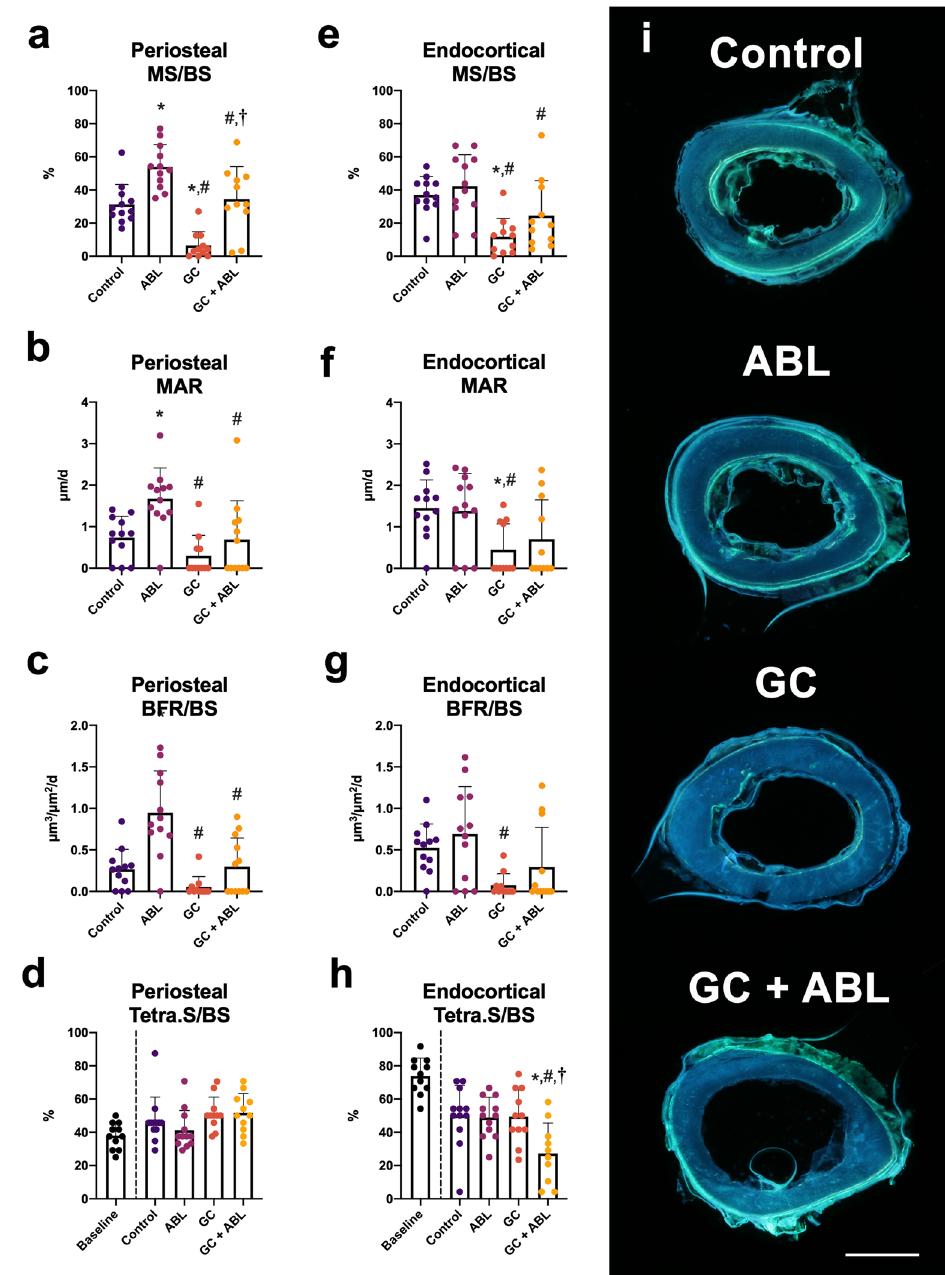
Figure 5. Mid-diaphyseal femoral cortical bone parameters determined by dynamic bone histomorphometry. ( a – d ) Periosteal envelope. ( e – h ) Endosteal envelope. ( i ) Representative histological sections from the four treatment groups. Bar = 0.5 mm. MS/BS mineralizing surface, MAR mineral apposition rate, BFR/BS bone formation rate, and Tetra.S/BS Tetracycline-covered surfaces. Mean ± SD. An interaction was found between treatment with ABL and GC for periosteal BFR/BS ( p = 0.033) and endocortical Tetra.S/BS ( p = 0.012). * p < 0.05 vs. Control. # p < 0.05 vs. ABL. † p < 0.05 vs.